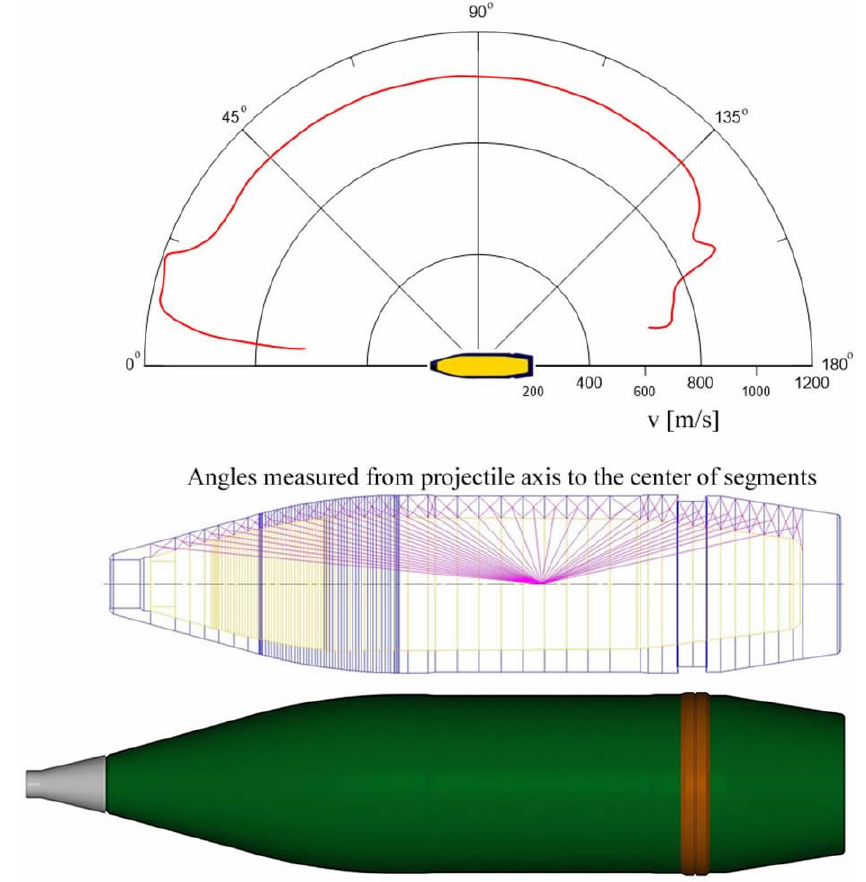
Figure 9. Variation of initial fragment velocity for 122mm HE OF-462 projectile as a function of segment position, presented using the polar diagram [adapted from 20]